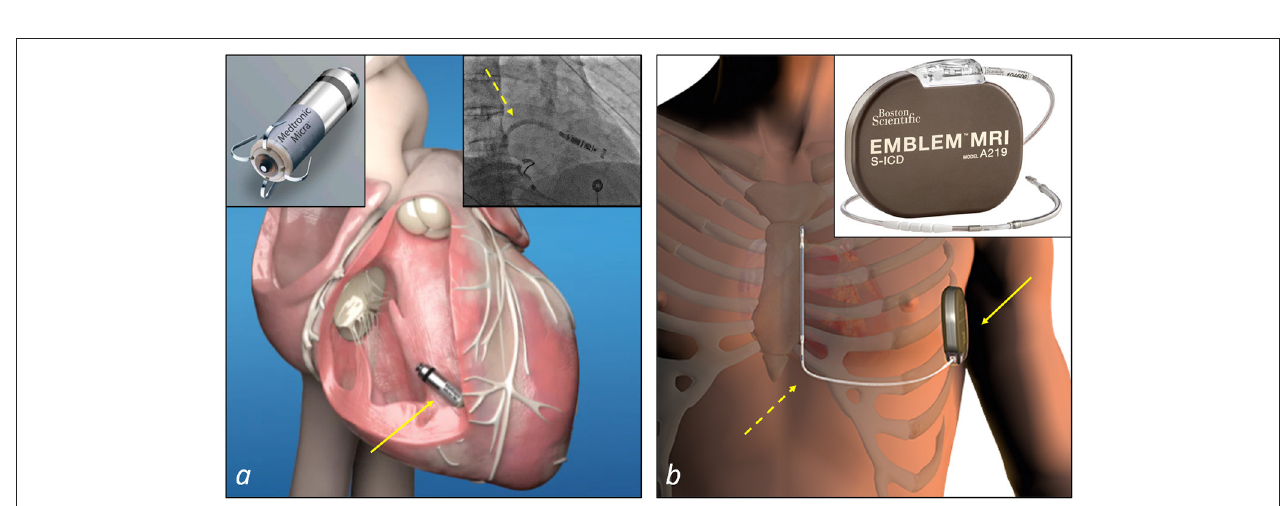
FIGURE 4 | Examples of non-transvenous CIEDs systems to deliver cardiac pacing or defibrillation therapy. (a) A leadless PM (Micra TM Medtronic, top-left corner) and the site of implant at the apical-septal level of the right ventricle (arrow). The insert at the top right corner shows a step of a Micra TM implantation: the catheter delivery system (dashed arrow) is advanced into the right ventricle to deliver the device. (b) A subcutaneous ICD (Emblem TM MRI Model A219, Boston Scientific, top-right corner) and the site of implant of the device (solid arrow) and the lead (dashed arrow). The device is implanted in the left axillary region in an intermuscular pocket created between the serratus anterior and the latissimus dorsi muscles, and connected to the lead implanted in the subcutaneous tissue of the parasternal region of the